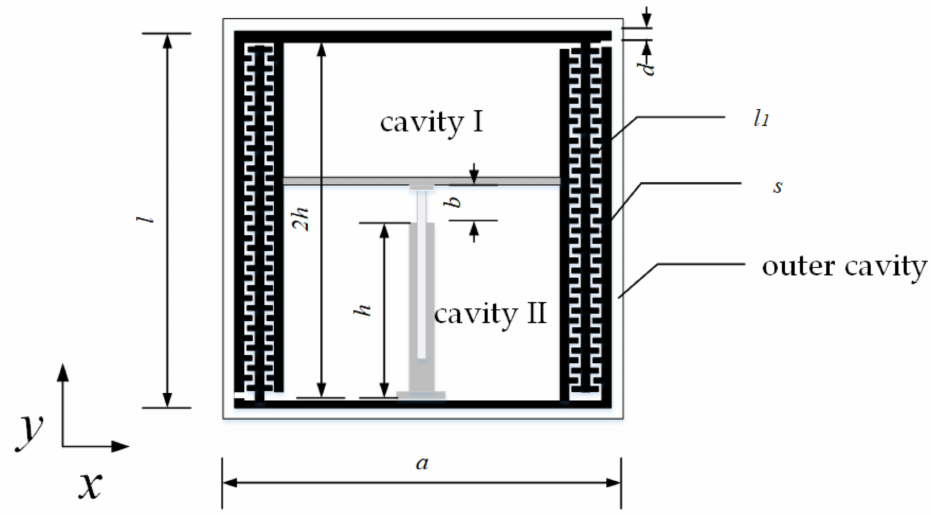
Figure 2. Cross section of the